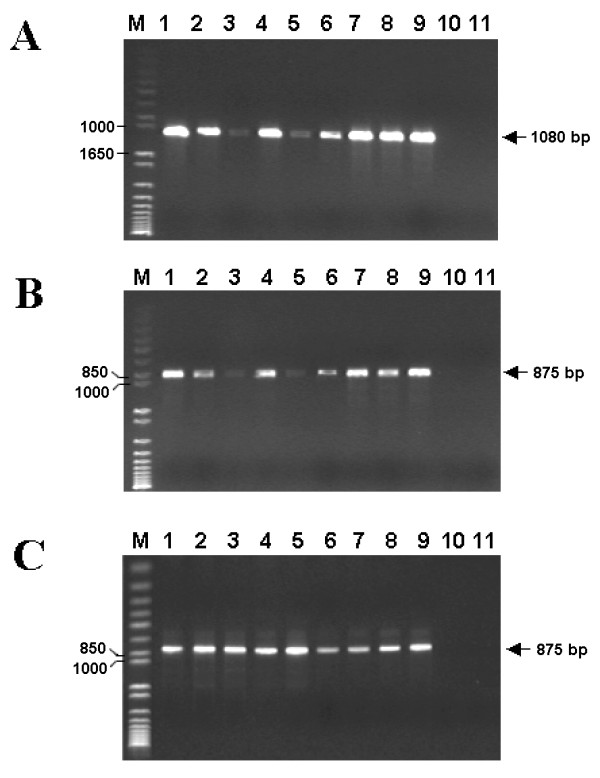
Detection of G. abietina in P. contorta trees. Lanes 1–6: needles from six infected twigs. Lanes 7–9: positive controls using G. abietina DNA. Lane 10: healthy P. contorta. Lane 11: negative control. M: 1 kb Plus DNA Ladder (Invitrogen). Panels A, B and C show the nested PCR results of NS1/8-NS.Grem3/4, NS1/8-NS.Grem5/6 and NS.Grem3/4-NS.Grem5/6, respectively.